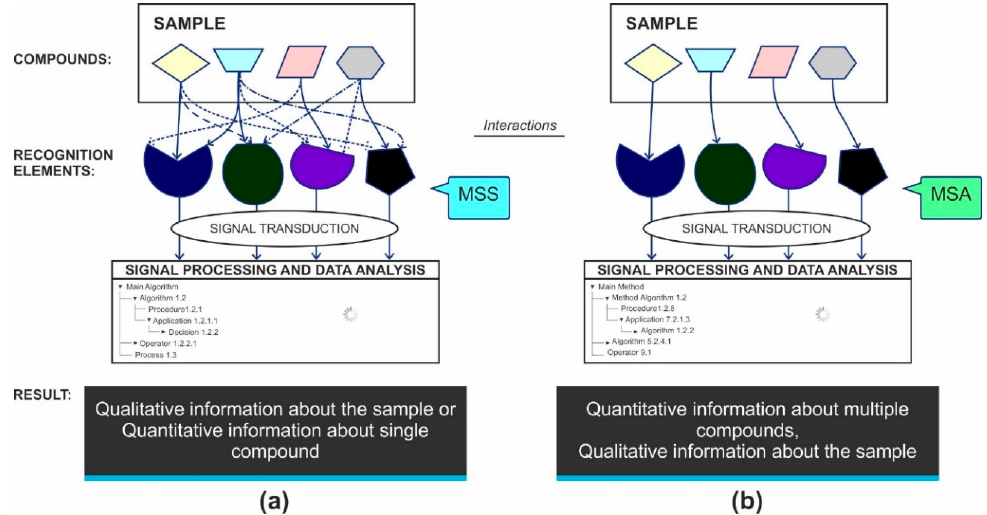
Figure 2. Schematic representation of the sample analysis path for an MSS ( a ) and an MSA ( b ) with recognition elements.